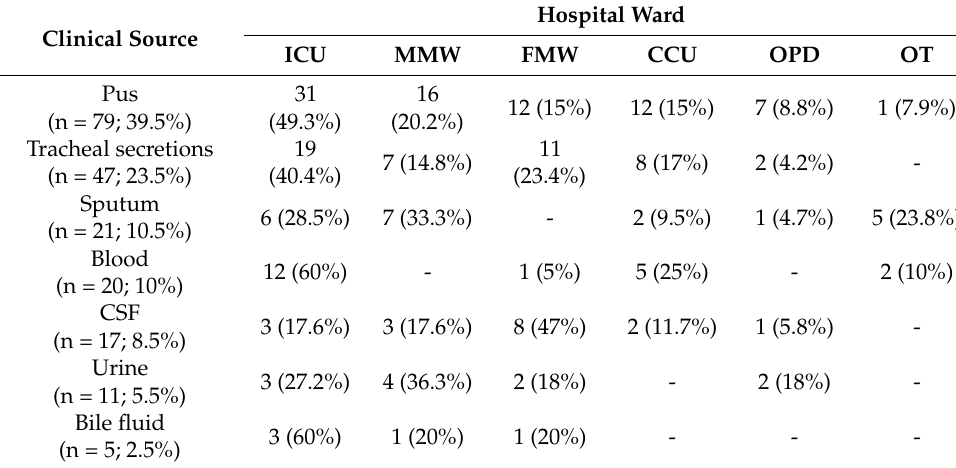
Table 2. Dissemination of CRACB from clinical sources and hospital wards.